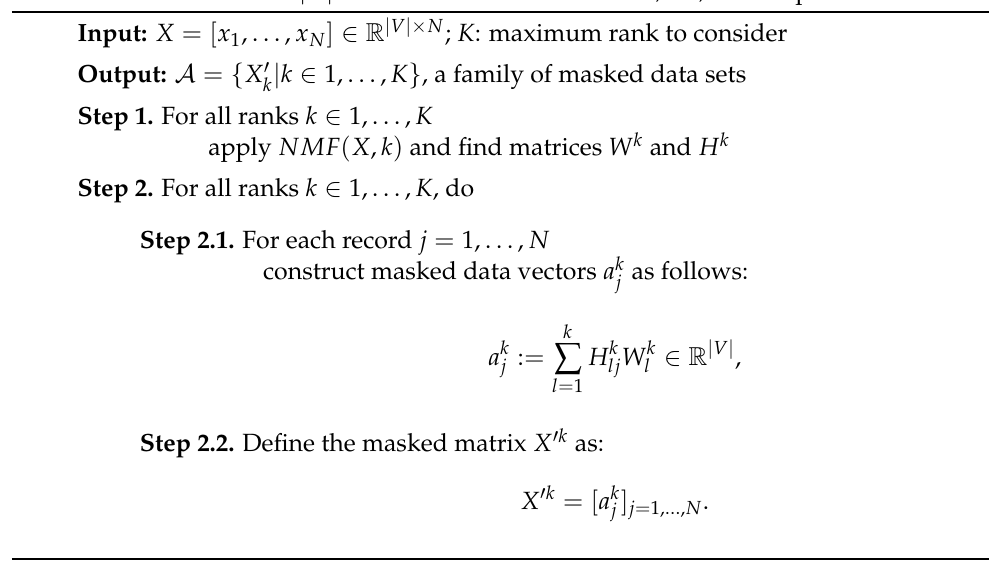
Algorithm 1: Algorithm for masking data using NMF. Here, X is the